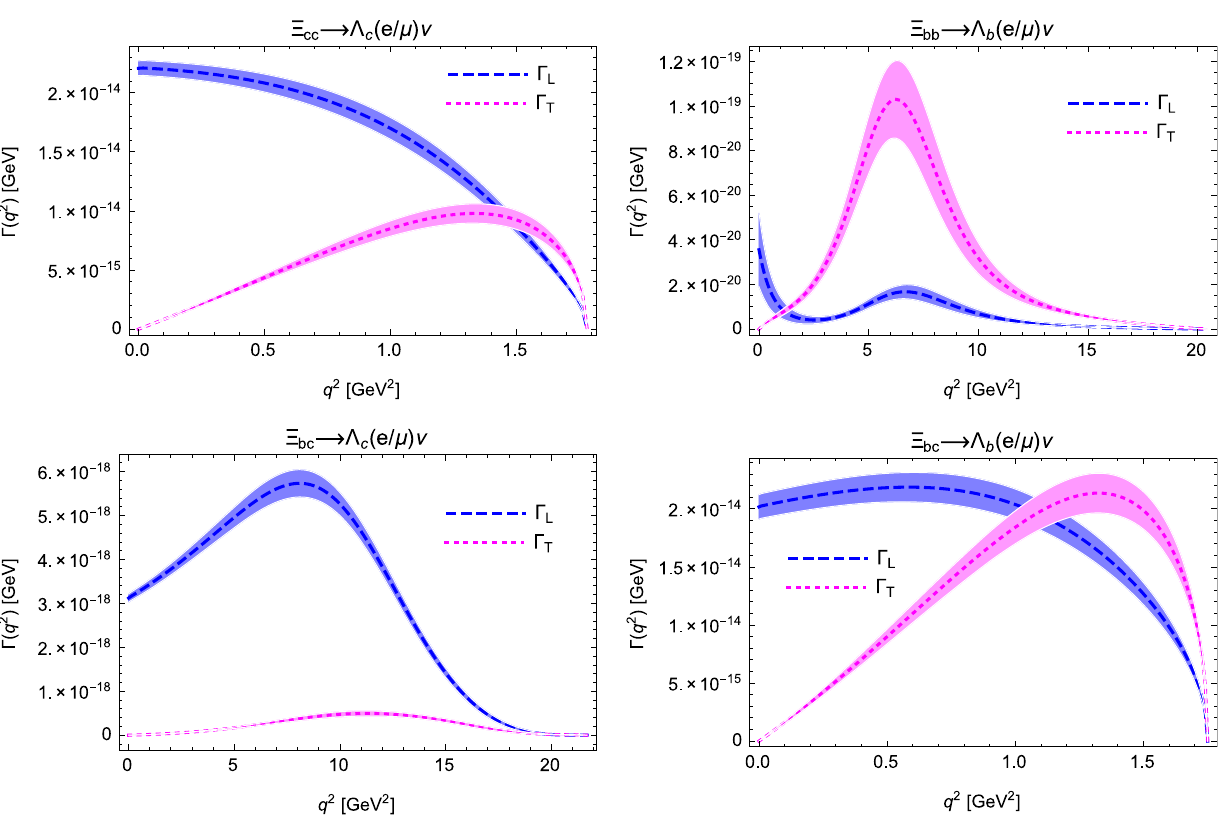
Fig. 3 q 2 dependence of the semi-leptonic (cid:3) QQ (cid:3) → (cid:2) Q (cid:3) l ν l decay widths. The blue bands correspond to (cid:20) L while the red bands correspond to (cid:20) T . The dashed lines describe the center value curves and the band width reflects the error Table 7 Comparison of the decay widths (in units of GeV) for the semi-leptonic decays in this work with the results derived from